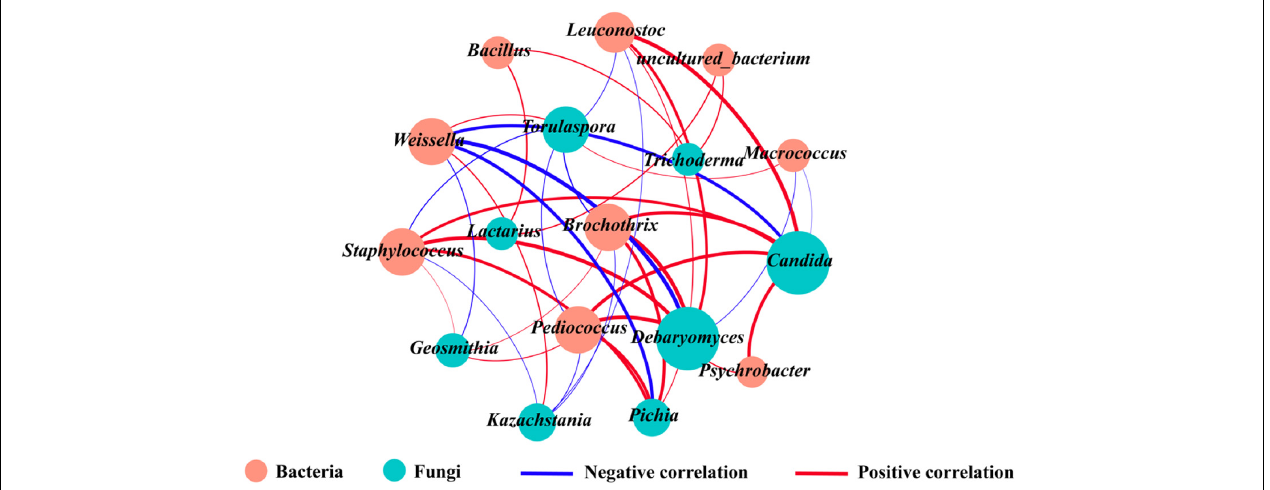
FIGURE 5 | Association network diagram of bacteria and fungi. The orange and green circles refer to bacteria and fungi, respectively, and the red and blue lines refer to positive correlations ( r > 0.7 and P < 0.05) and negative correlations ( r < − 0.7 and P < 0.05), respectively. (For interpretation of the references to color in this figure legend, the reader is referred to the web version of this article).